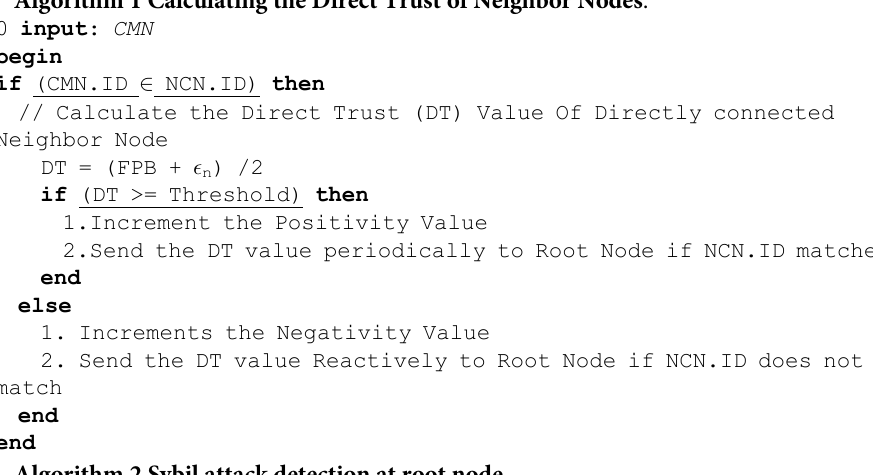
Algorithm 2 Sybil attack detection at root node